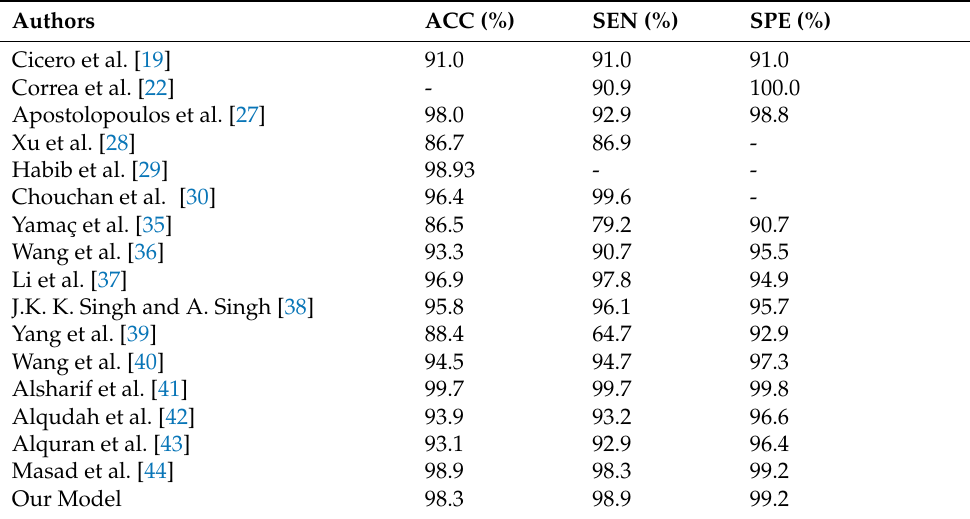
Table 6. Comparison table for the selected state of the art models using the same dataset. Model